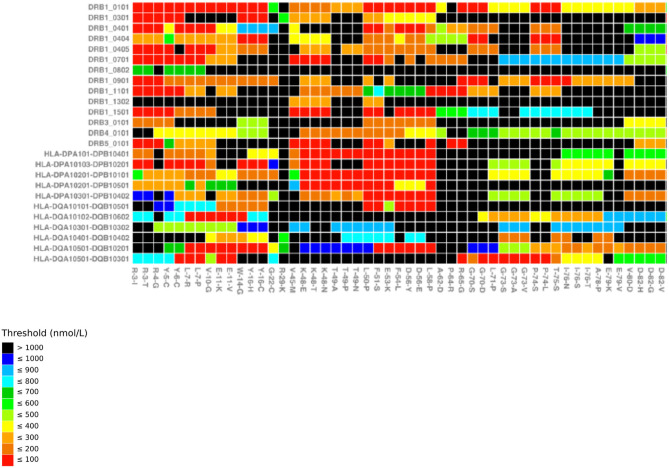
MHC-binding strengths of F8 peptides predicted to form novel pMHC surfaces. Heatmap showing the predicted occurrence of novel pMHC surfaces and binding strengths for 26 HLA-DR/DP/DQ alleles (y axis) covering the first 51 missense mutations in f8-db-eahad.org database (x axis). Black squares indicate F8 missense mutation/HLA allele combinations that are not predicted to form a novel pMHC surface. Otherwise the temperature color scale indicates the predicted binding strength of the strongest binding peptide with a novel pMHC surface for each remaining F8 missense mutation/HLA allele combination (31).